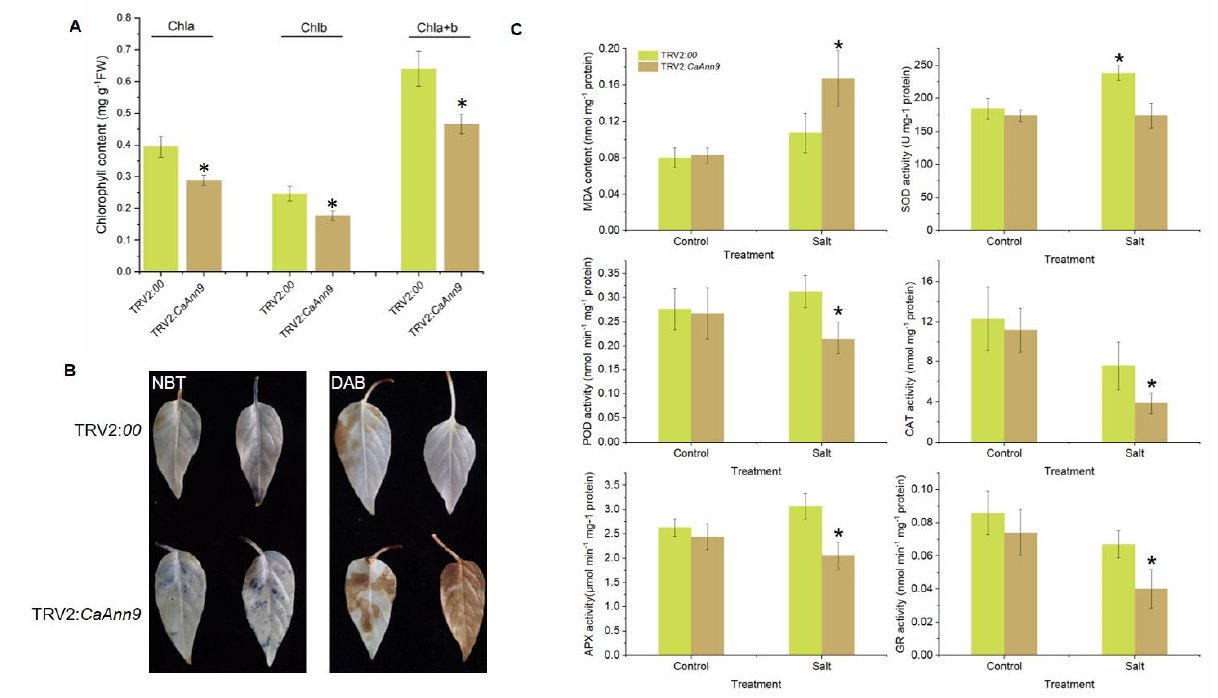
Figure 8. The oxidative damage in CaAnn9- silenced plants under salt stress. ( A ) The content of chlorophyll a (Chla), chlorophyll b (Chlb), and total chlorophyll (Chla+b) in the leaves of CaAnn9- silenced seedlings after 7 days 200 mM NaCl stress. ( B ) NBT and DAB staining in leaves of CaAnn9 -silenced plants after 7 days of 200 mM NaCl stress. ( C ) The activities of ROS-scavenging enzymes in the leaves of CaAnn9 -silenced plants after 7 days of 200 mM NaCl stress. Membrane lipid peroxidation products MDA, SOD, POD, CAT, APX, and GR activities were determined. * Represents statistically significant values at p ≤ 0.05. Error bars represent SD values of three replicates.